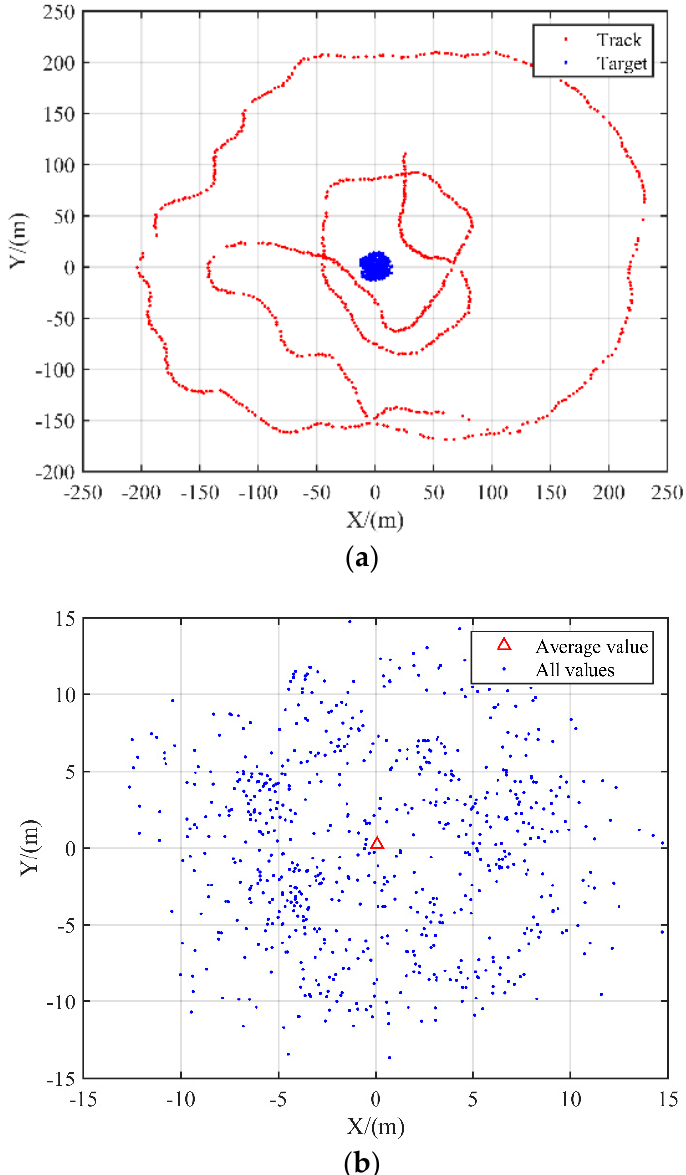
Figure 7. ( a ) Ship’s trajectory and USBL positioning results; ( b ) enlarged view of USBL positioning results and the mean value of all the results.